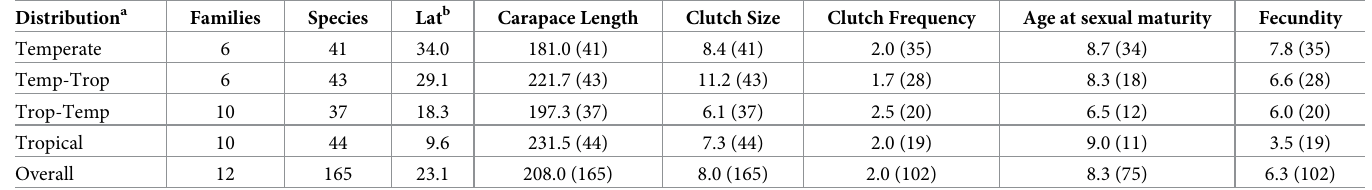
Table 1. Demographic parameters in freshwater turtles. Demographic parameters used in population modelling to estimate capacity for sustainable harvest in freshwa- ter turtles. Estimates are median values derived from the scientific literature (S1 Table) and summarized based on the species distributions across four latitudinal classes. Values in parentheses are the number of species with data available and used to calculate